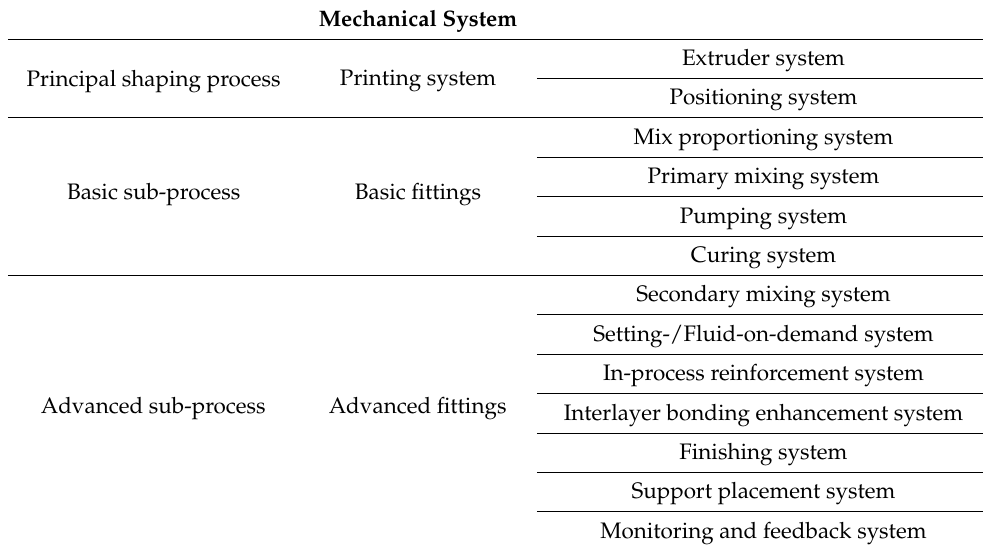
Table 1. E3DCP mechanical